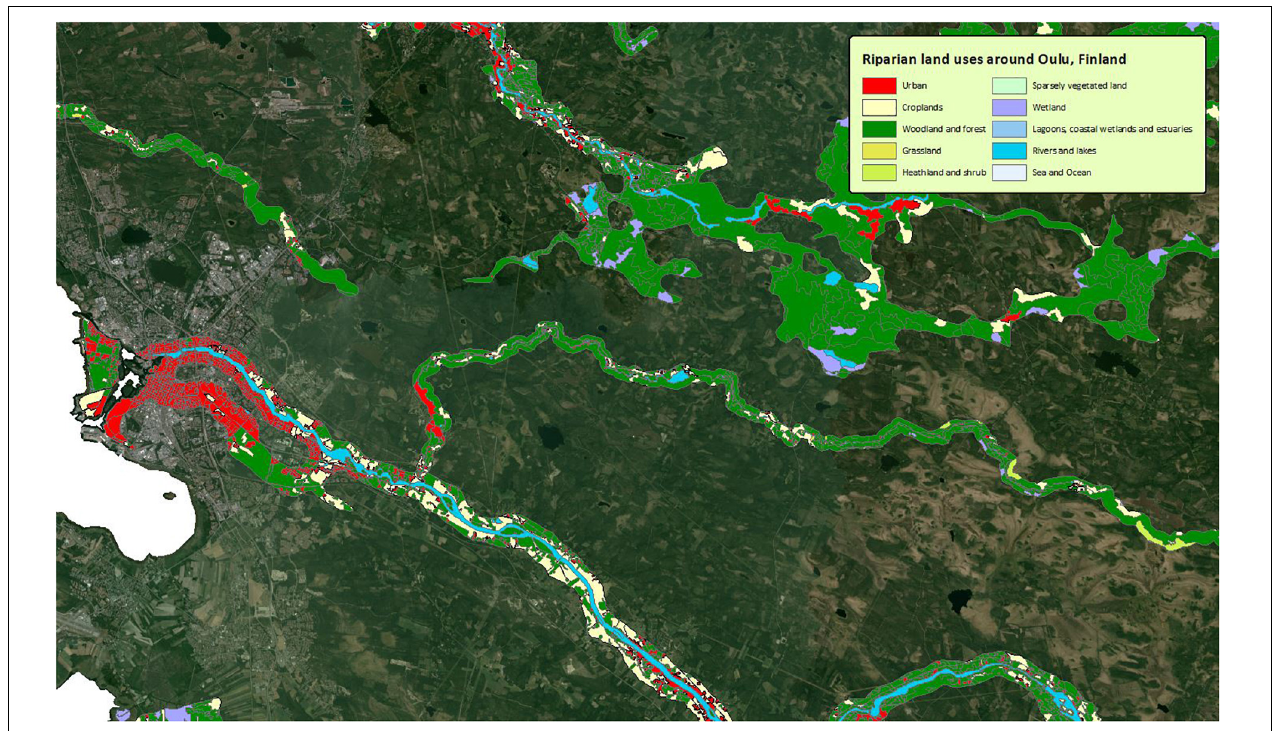
FIGURE 6 | Riparian land uses in the surroundings of Oulu, Finland. Based on the Copernicus Land Cover/Land Use classification (Forslund, 2012) and the VHR2018 dataset from the European Environmental Agency. ©OpenStreetMap, and the GIS user